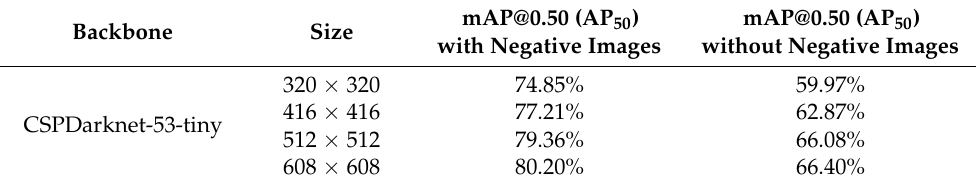
Table 2. Comparison between models trained with/without negative